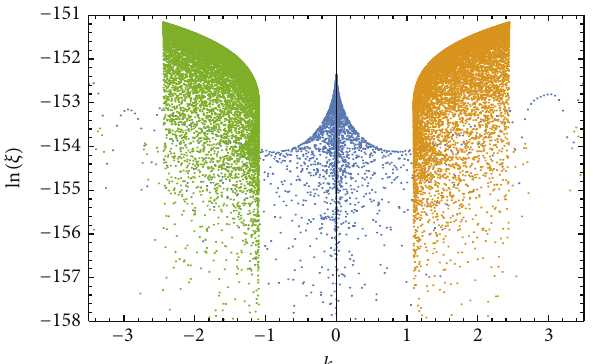
Figure 4: Radiation power for 𝑡 = 0 , 𝑥 = 250 , 𝜆 = 10 −5 , 𝜖 = 0.01 , 𝑎 = 1.2 , and 𝑏 = 0.01 . The blue dots are the values in the range −0.33674 < 𝑘 < 0.33674 , the green dots correspond to the range 𝑘 < −0.920112 , and the orange dots correspond to the values in the range 𝑘 > 0.920112 .